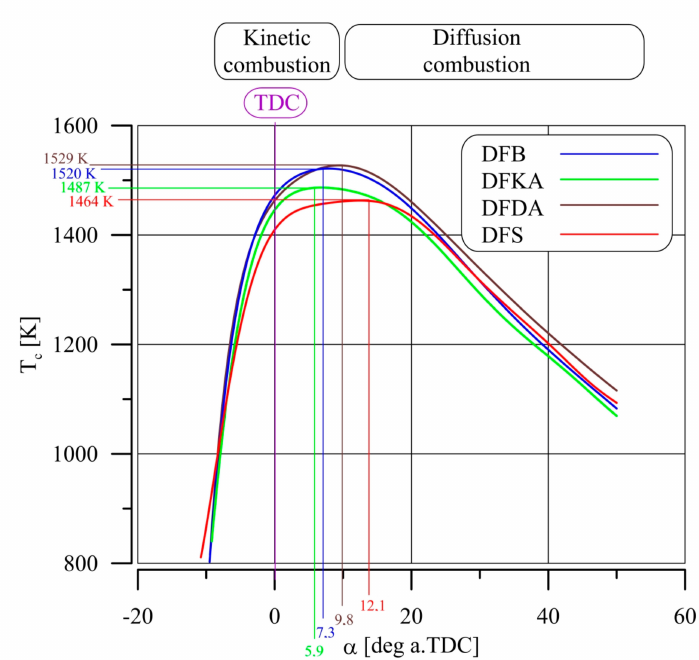
Figure 16. Course of combustion temperature, determined from indicator charts for tested